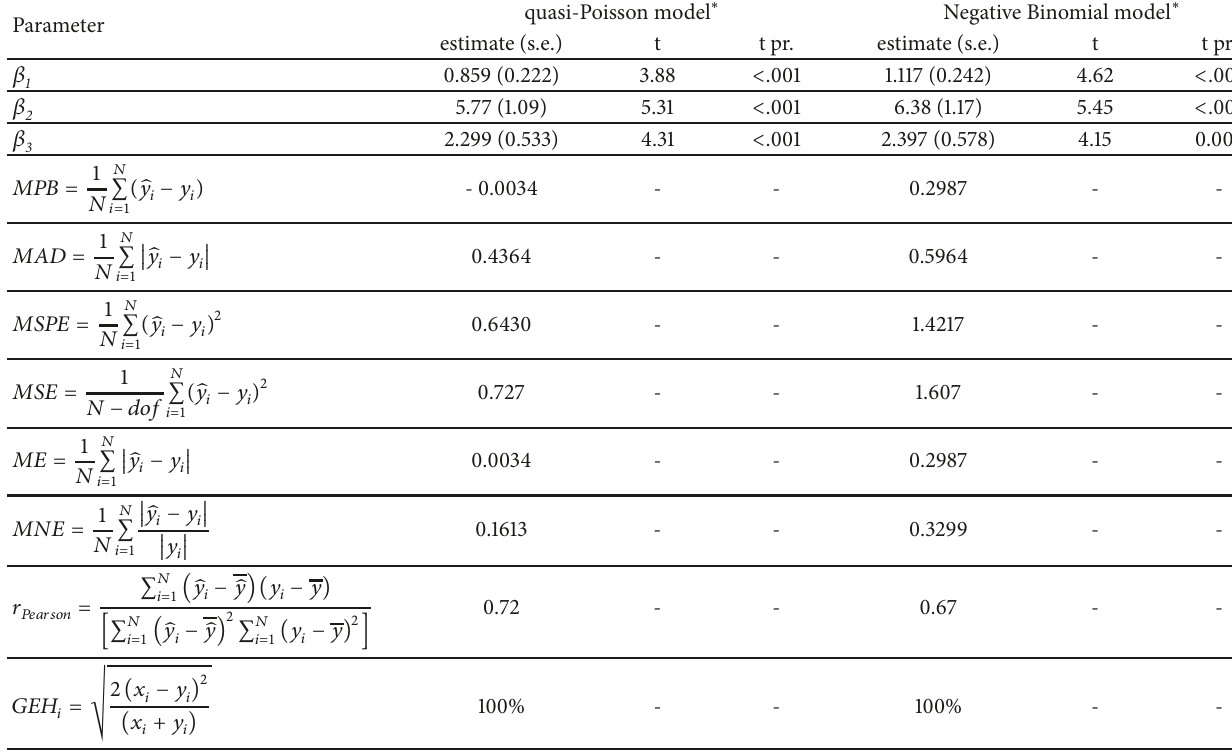
Table 8: Parameter estimates for crash models based on AIMSUN simulated conflicts and goodness-of-fit. Parameter